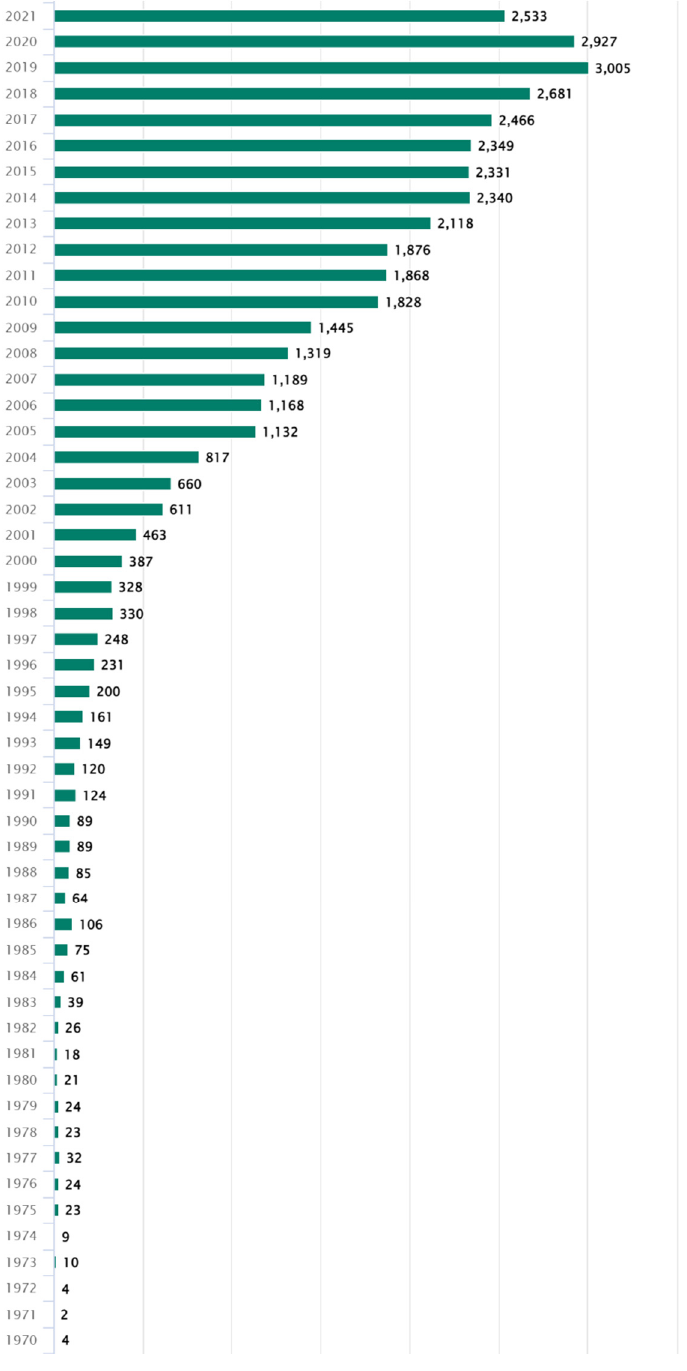
Figure 2. Compendex research records on the 3D product model with an assembly reference over time.